Question: Write the caption for this figure.
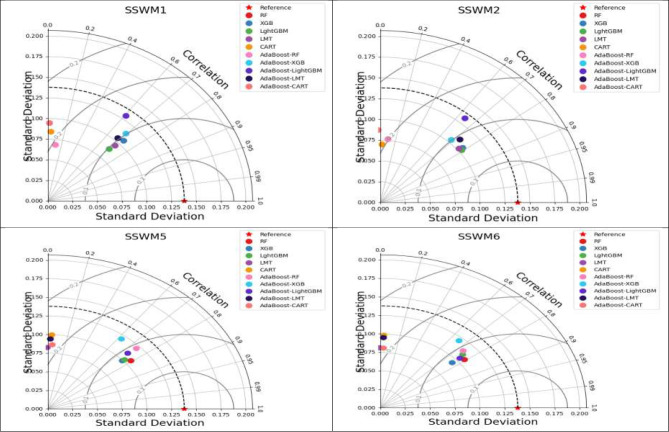
Answer: Taylor diagram showing the relationship of correlation coefficient between observed and predicted models of SSW in Hoshiarpur during testing of the models.